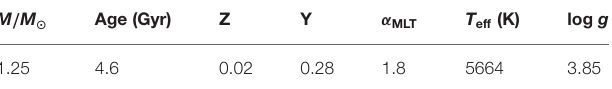
TABLE 1 | Subgiant model parameters.